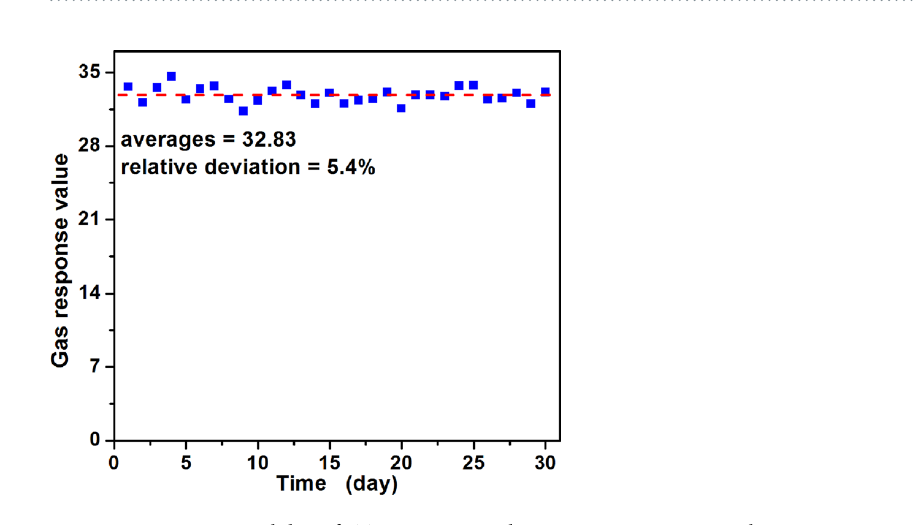
Figure 9. Long-term stability of PTO-4 nanoparticles gas sensor to 3000 ppm butane at 340